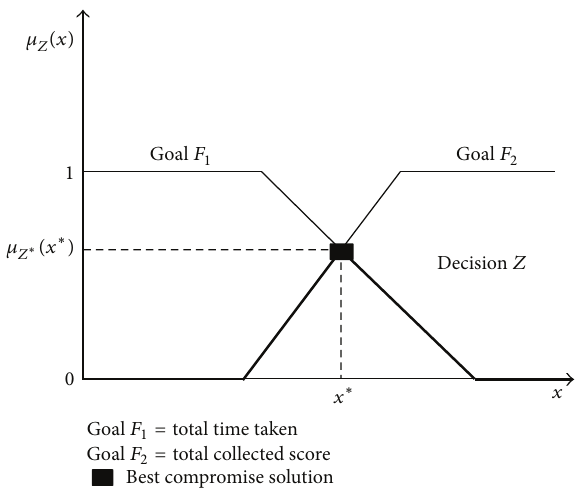
Table 1: The values of edge weights (time taken to travel from one node to another).